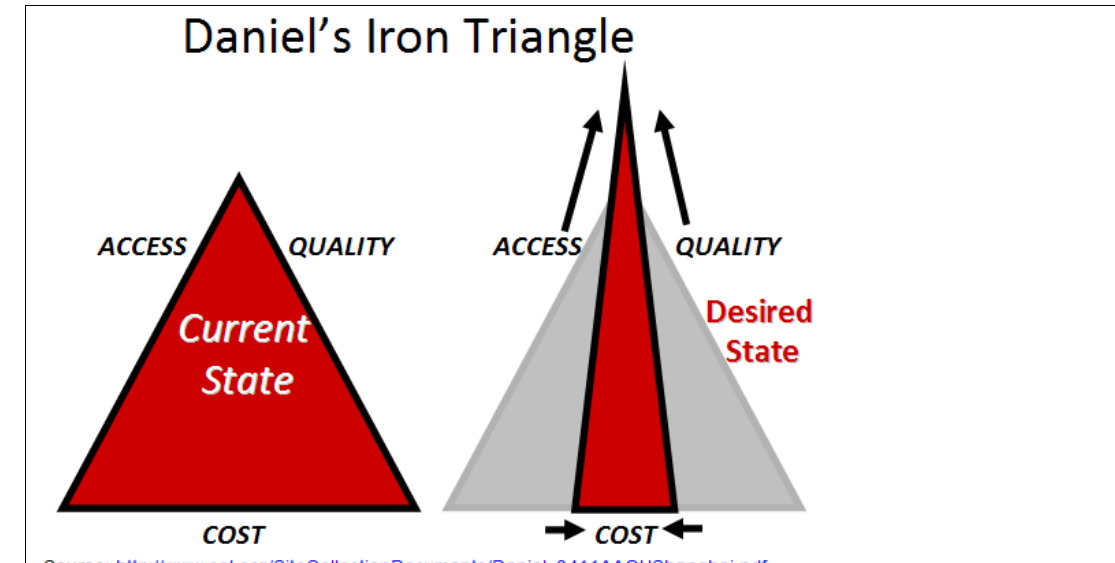
Figure 1 . Daniel’s iron triangle, presenting both the current state of affairs and the desired state made possible by universities implementing wide-scale distance